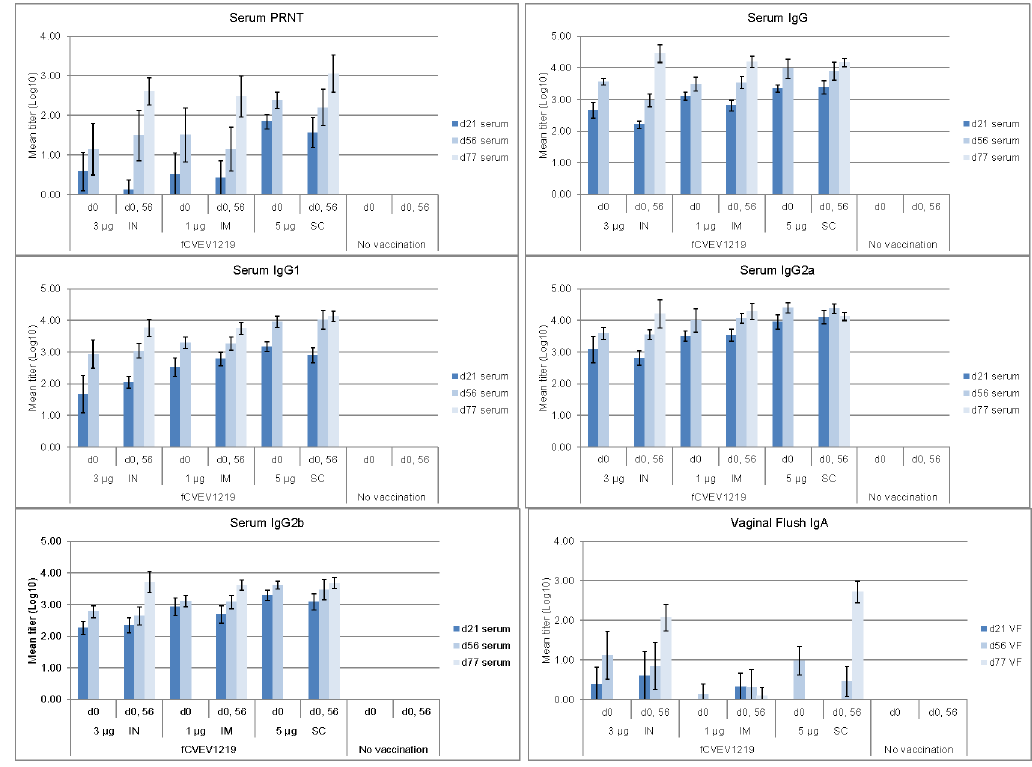
Figure 9. Serum and vaginal flush antibody responses in mice vaccinated with fCVEV1219 vaccine candidate. Groups of BALB/c mice (n=10) were vaccinated once (d0) or twice (d0, 56) with fCVEV1219 at doses ranging from 5–1 m g by the IN, IM, or SC route. Serum and vaginal flush samples were collected on day 21, 56, and 77 post-vaccination. Neutralizing antibody responses were determined by PRNT and serum and vaginal flush antibody levels were determined by ELISA. Dark bars represent the mean group titer 21 days after the first vaccination (n=10); medium bars represent the mean group titer 56 days after the first vaccination (n=10); light bars represent the mean group titer 21 days after the second vaccination (day 77, n=10). Standard error bars represent 2 times the SE of the mean (SE=SDxsqrt(n)).